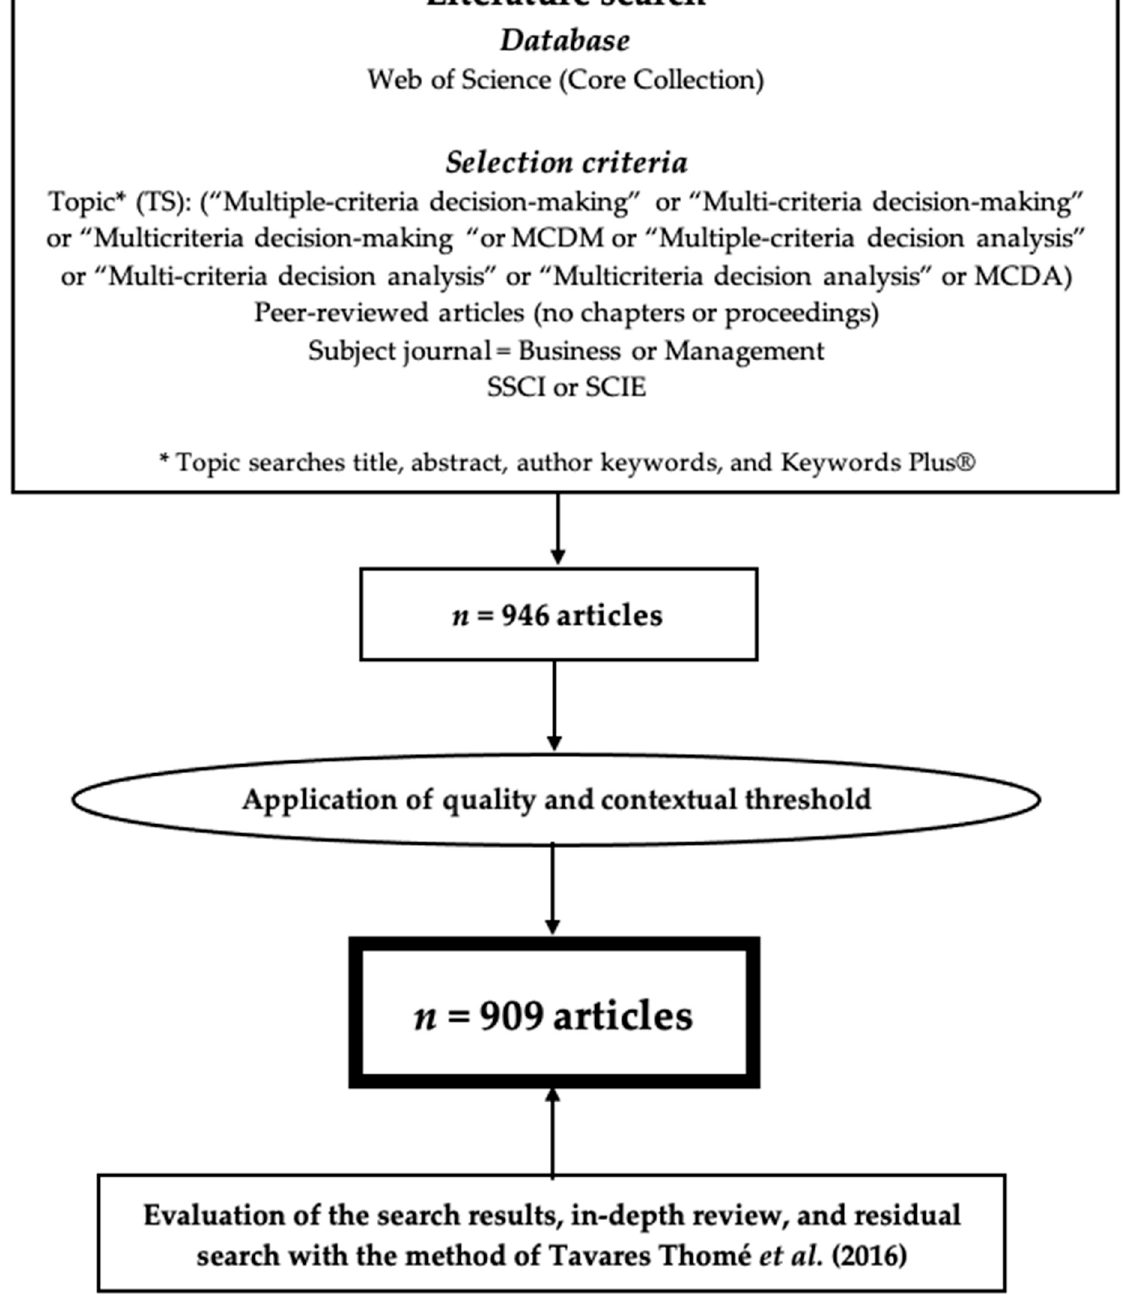
Figure 1. Systematic literature review strategy [58].